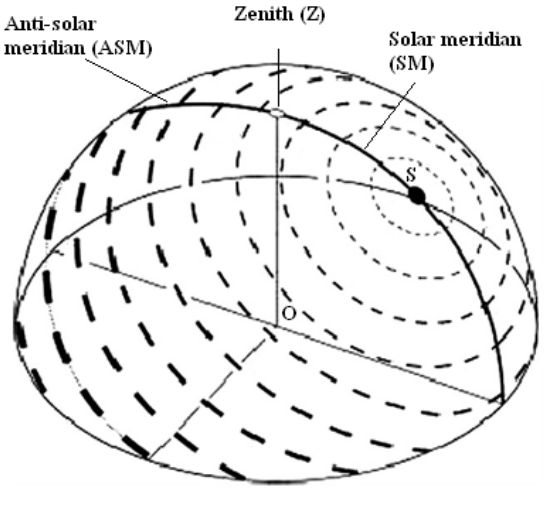
Figure 3. Three-dimensional representation of the pattern of polarization in the sky as experienced in point O. Orientation and width of the bars depict the direction and degree of polarization, respectively. A prominent property of the pattern is a symmetry line running through sun (S) and zenith (Z), called “solar meridian” (SM) on the side of the sun and “anti-solar meridian” (ASM) on the opposite side